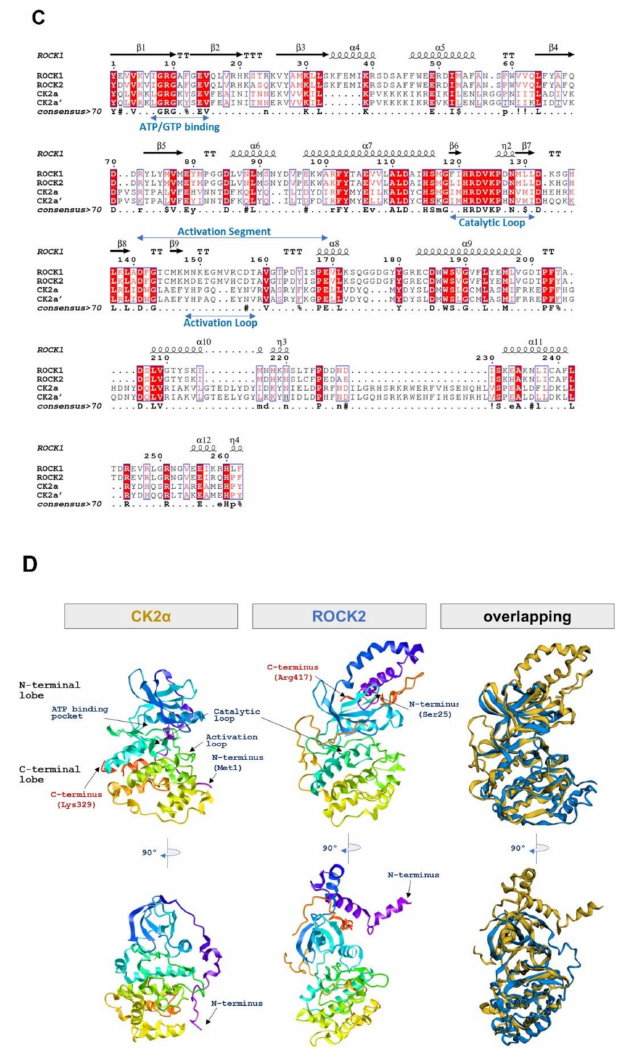
Figure 4. Sequence alignment and structural comparison of CK2 and ROCK2. ( A ) Structure of ROCKs and CK2 isotypes. ROCKs are relatively long but CK2 isotypes are short. ROCKs have the kinase domain at N-terminal region which is a conserved region among kinases. ( B ) Sequence alignment of the kinase domain of CK2 α (aa 39–324) and ROCK2 (aa92–354) by the Needleman–Wunsch global alignment algorithm using BLAST software. Several known kinase motifs were indicated in blue color box (the HRD, DFG, and APE motifs). ( C ) Multiple sequence alignment of human ROCKs and CK2 proteins in the kinase domain. The alignment was performed using COBALT alignment tool and the result was displayed using ESPript (Version 3.0, http://espript.ibcp.fr/, accessed on 4 August 2021). The kinase domains were used for multiple alignment as described in Table 1. The Secondary structural elements for ROCK2 are displayed above and the consensus sequences are noted below sequences. Several conserved motifs were marked by bidirectional arrows in blue color with descriptions. ( D ) Structural alignment of CK2 α with ROCK2 covering the kinase domain.